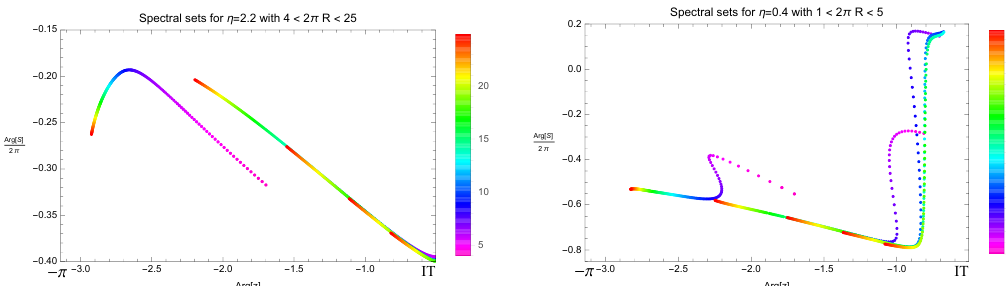
Figure 5. A demonstration of finite size effects in the spectral sets, computed using TFFSA at truncation level L = 22 for two sample values of η . The vertical axis is the approximation to the elastic scattering phase extracted from the Bohr-Sommerfeld quantization condition, and the horizontal axis is arg( z ) (related to the energy via (2.14)). The value of the cylinder radius R is indicated by the color scheme, from red (large radii) to violet (small radii). For η = 2 . 2 , in the range − 2 . 7 < arg z < − 1 . 6 , the spectral set of the lowest 2-particle state at small radii and that of the second lowest 2-particle state at larger radii do not overlap, due to significant finite size effect in the former. To handle this problem, we discard a posterior the spectral set data for the lowest 2-particle state at 2 πR / 10 . The finite size effects are significantly smaller for the higher 2-particle states, as seen from their approximate overlaps. For η = 0 . 4 , finite size effects plague higher level 2-particle states as well for 2 πR / 3 , again in a clearly visible